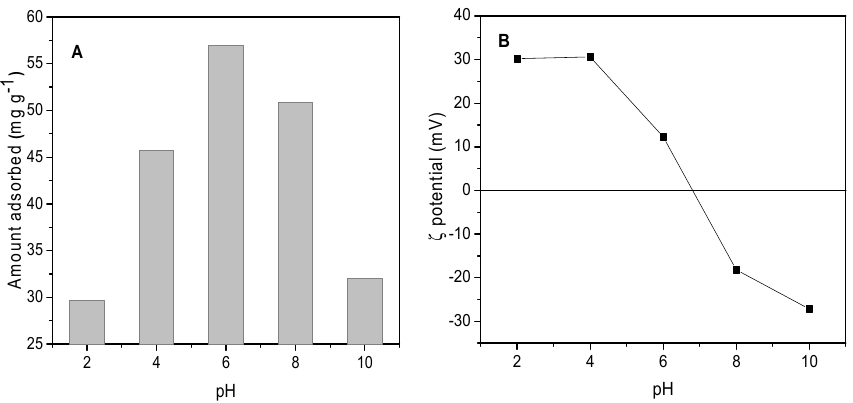
Figure 3. The amount of TC that was adsorbed versus solution pH ( A ), and the zeta potential measurement of maghemite ( B ).